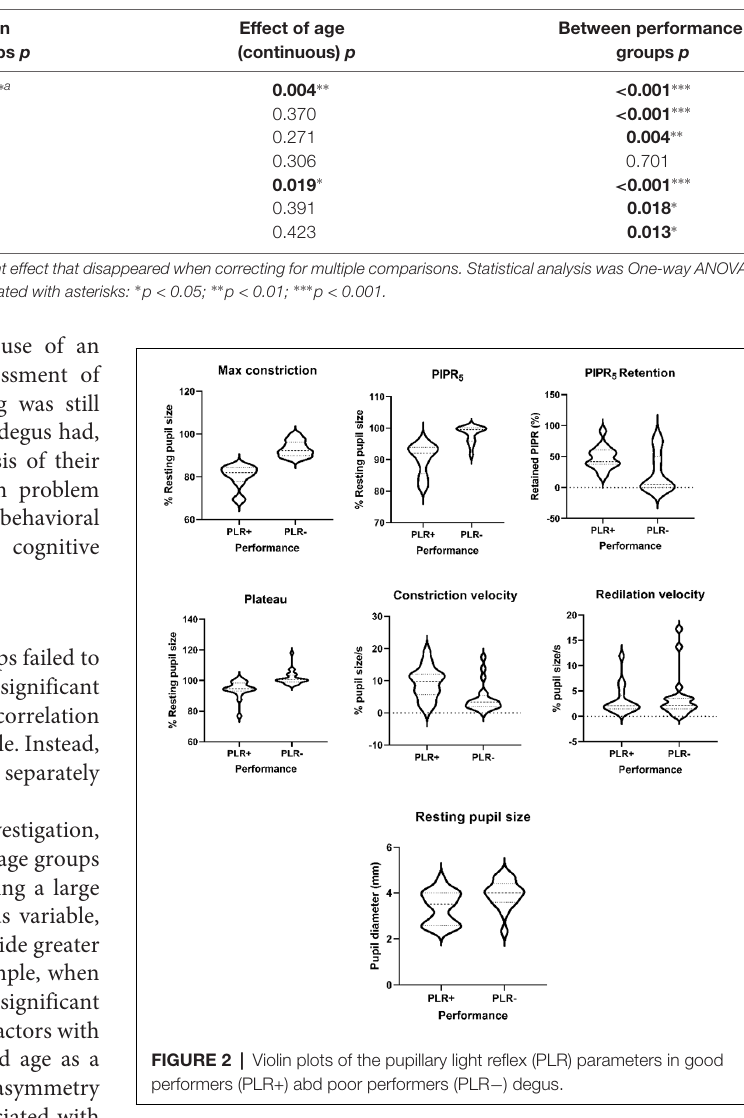
TABLE 6 | Summary of the statistical analysis of pupillary light reflex features.